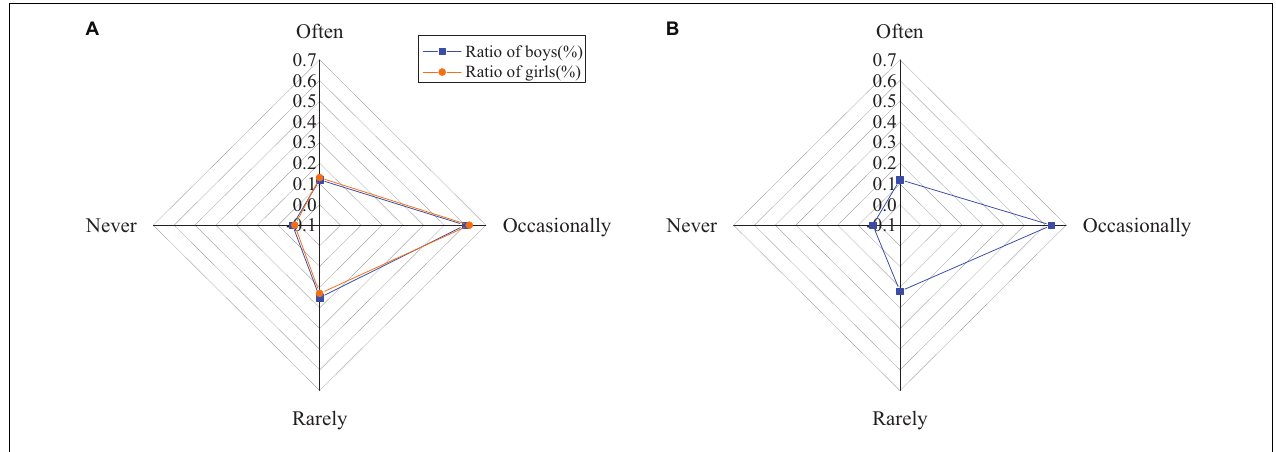
FIGURE 15 | The use of psychological knowledge by college students [ (A) the ratio of males and females; (B) the ratio of all].